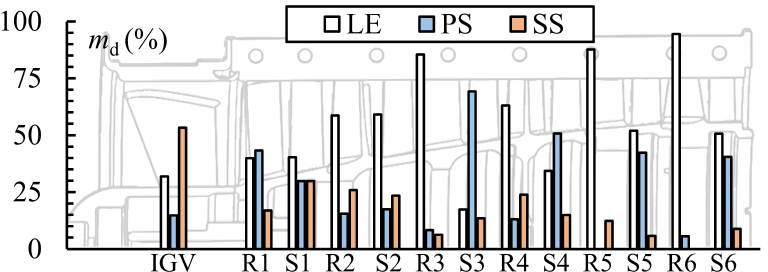
Figure 8. Percentage of the mass deposited on the leading edge (LE), pressure side (PS), and suction side (SS) with respect to the total mass deposited on the single